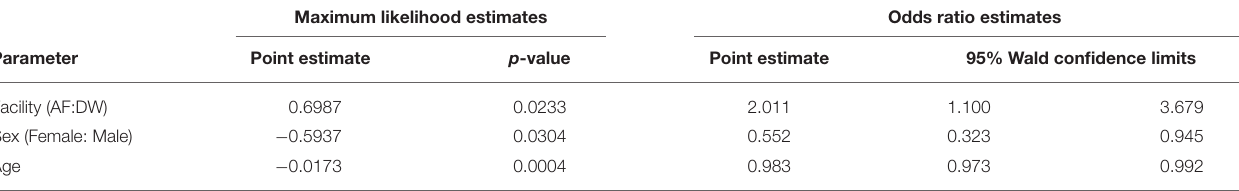
TABLE 3 | The influence of facility, sex and age on the prevalence of FP tested using logistic regression.